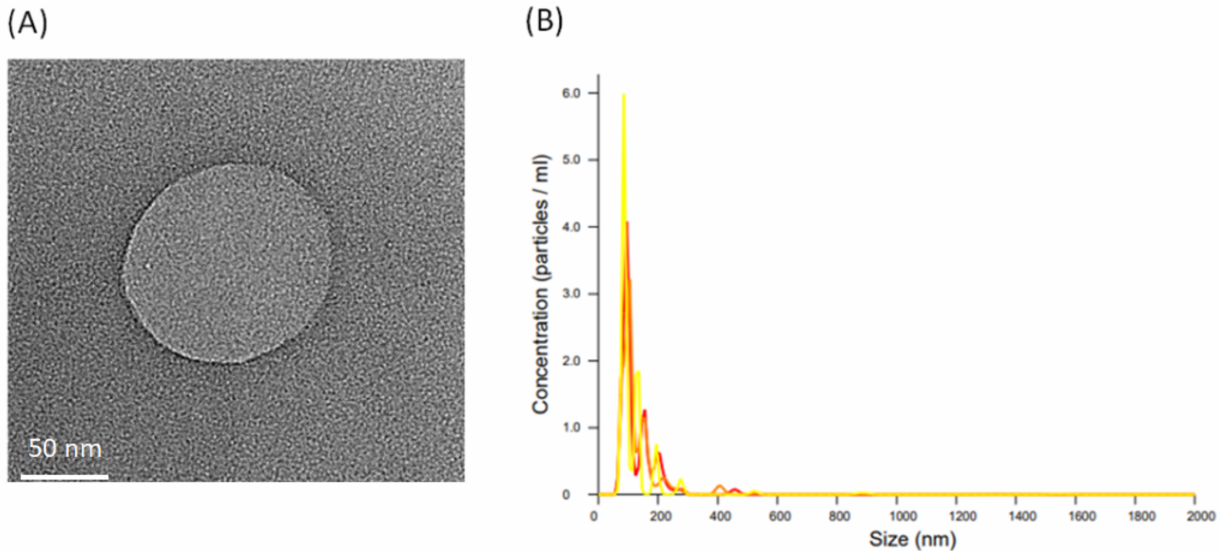
Figure 3. Characteristics of EVs secreted from L. crispatus . ( A ) The morphology of L. crispatus -derived EVs was showed via transmission electron microscopy (TEM). ( B ) The numbers and size distribution of L. crispatus -derived EVs. L. crispatus were incubated for 48